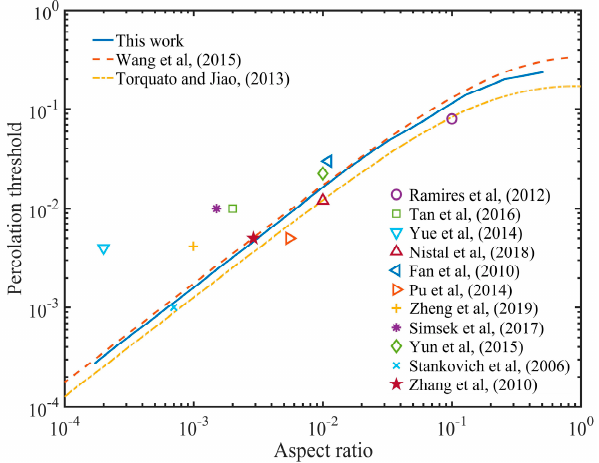
Figure 9. Percolation threshold versus aspect ratio.